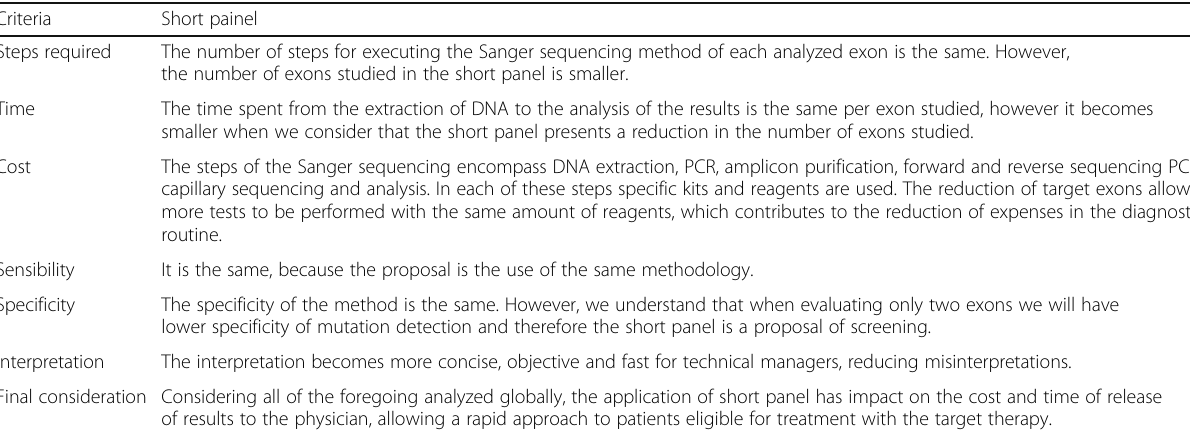
Table 2 Analysis criteria that mention why use the short panel